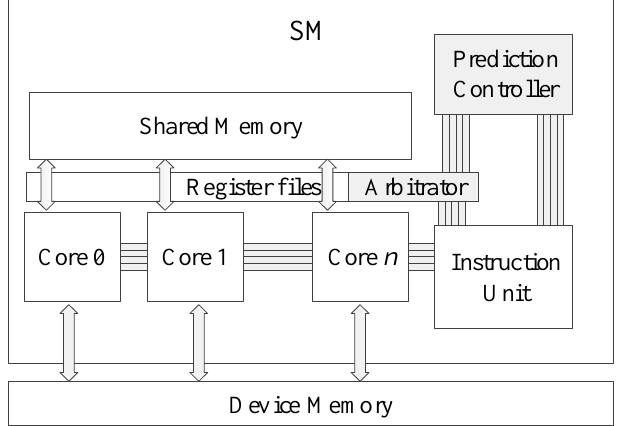
Figure 4. Overview of the proposed microarchitectural hardware support.